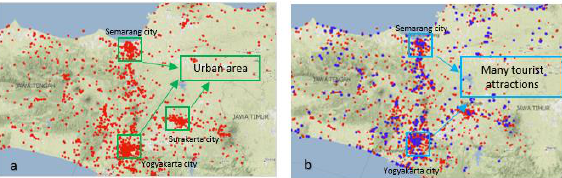
Figure 4.3. (a) Comparison of tourist distribution from big data Instagram with urban area; (b) Comparison of tourist distribution from big data Instagram with tourist